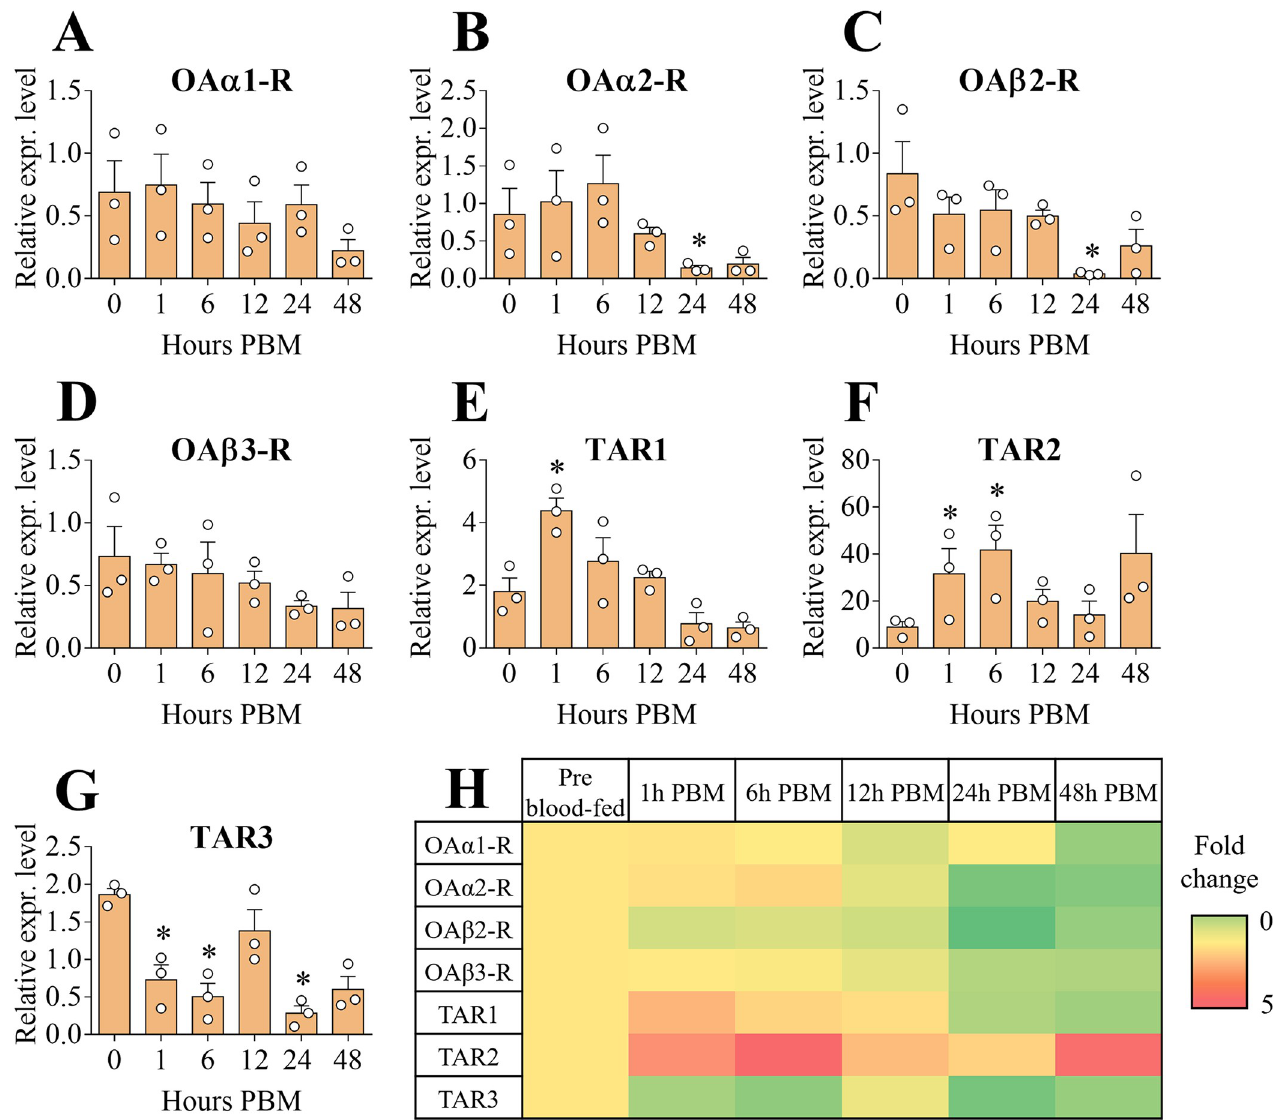
Fig 7. Expression patterns of OA and TA receptor transcripts among female adult A . aegypti ovaries post blood meal (PBM) time points. AaOA α 1-R ( A ), AaOA α 2-R ( B ), AaOA β 2-R ( C ), AaOA β 3-R ( D ), AaTAR1 ( E ), AaTAR2 ( F ) and AaTAR3 ( G ). Setting all the receptor expression levels in pre blood-fed condition to 1, a heat map was assembled ( H ). Data represent means ± SEM of three biological replicates. � p < 0.05 vs pre blood-fed condition (0 hours PBM) according to one-way ANOVA followed by multiple comparisons Bonferroni post hoc